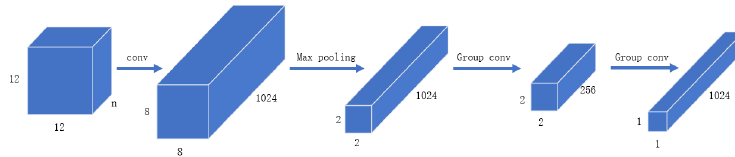
Figure 4. CNN structure diagram in Glyce.